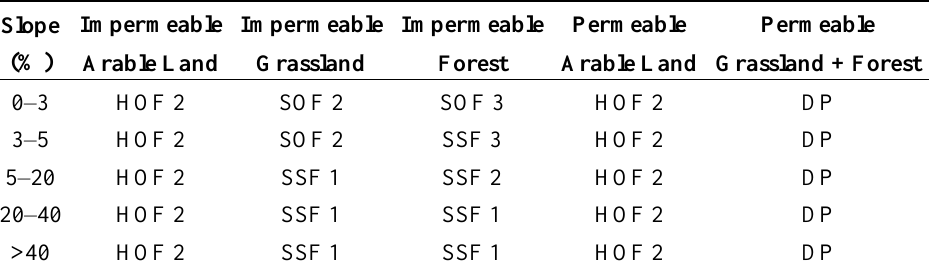
Table 4. GIS-DRP table topsoil sealing .